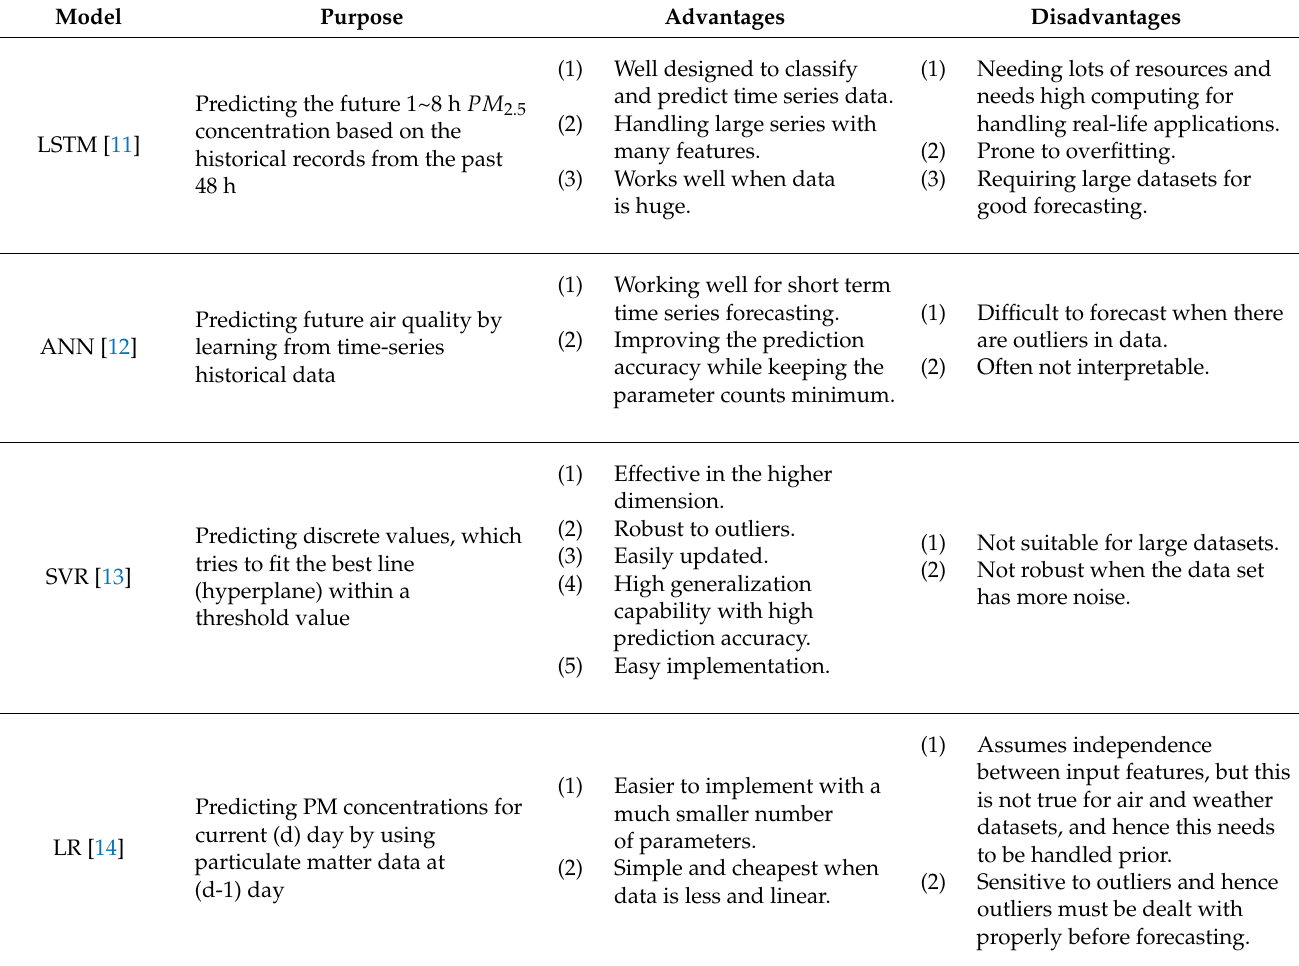
Table 3. Comparison of forecasting and regression models (created by